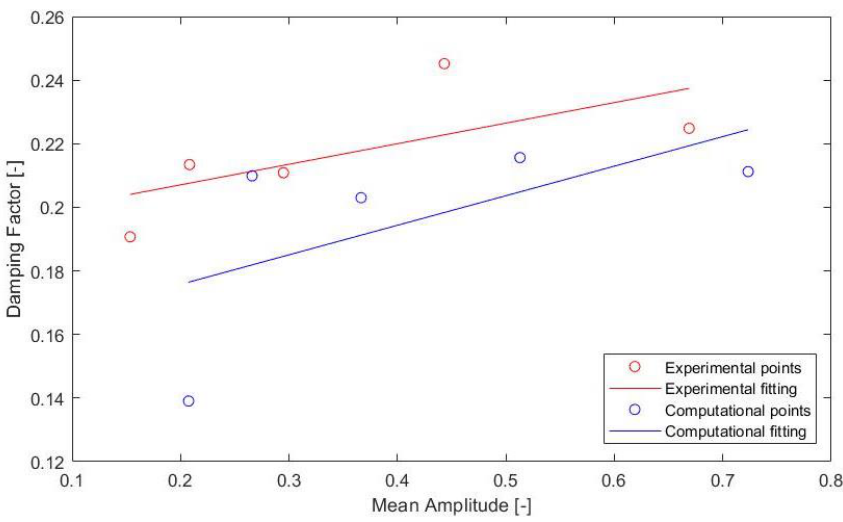
Figure 10. Damping factor study between the experimental and computational tests with linear fitting of both.